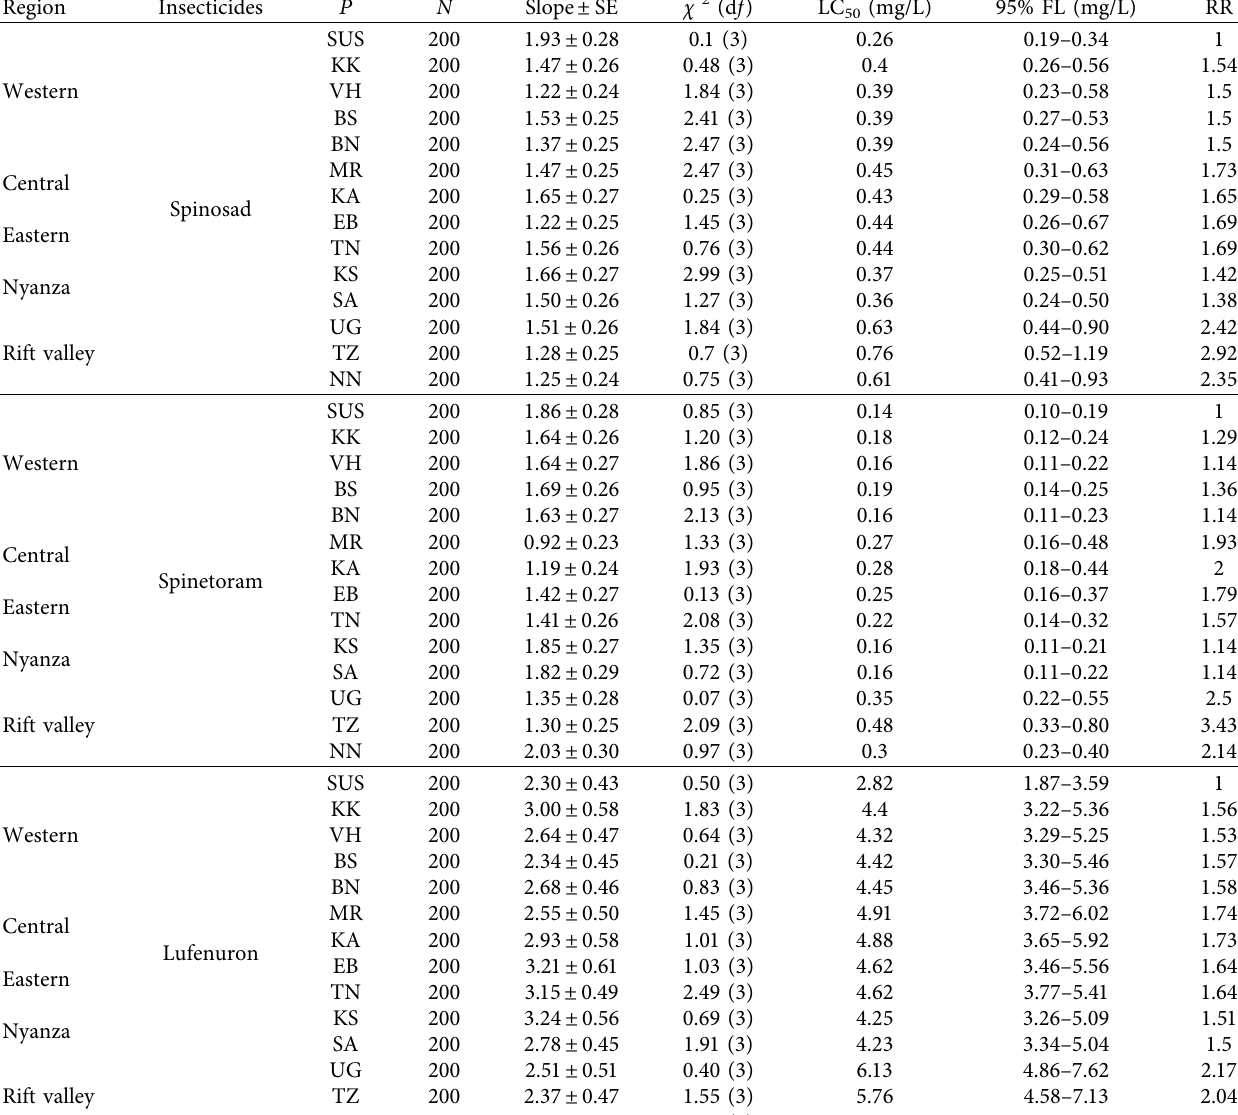
Table 5: Susceptibility of field populations of Spodoptera frugiperda to spinosad, spinetoram, and lufenuron.